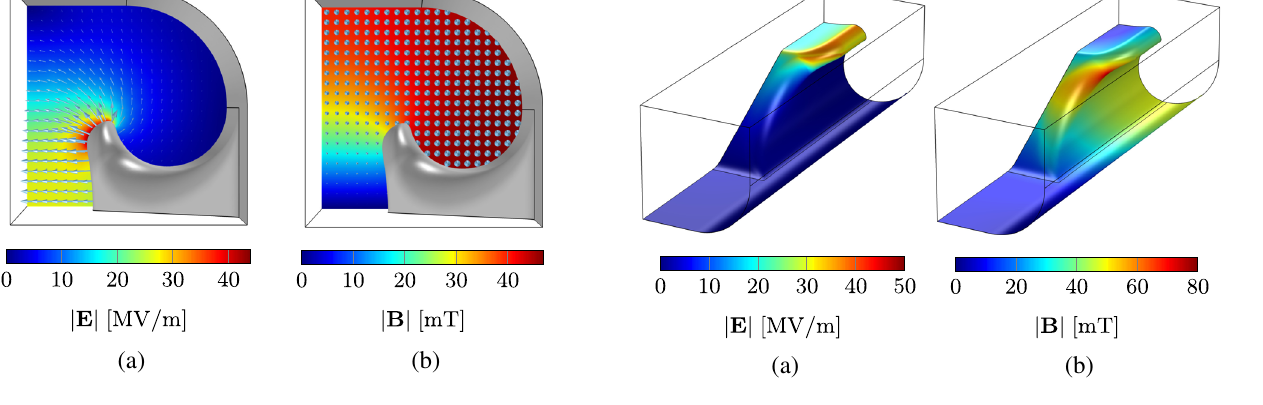
FIG. 2. Quarter of the transverse cross section at the cavity center. The electric (a) and magnetic (b) fields of the TE 111 -like fundamental mode are scaled to the nominal deflecting voltage of V ⊥ ; 0 ¼ 3 MV.